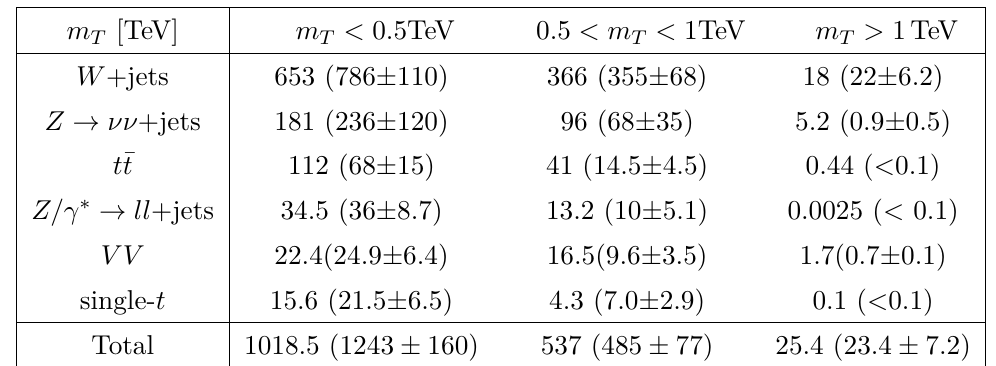
Table 1 . Expected number of events in the SM from our simulation, for integrated luminosity of 35.9 fb − 1 . The numbers in parenthesis are the CMS result in [30] with associated total systematic